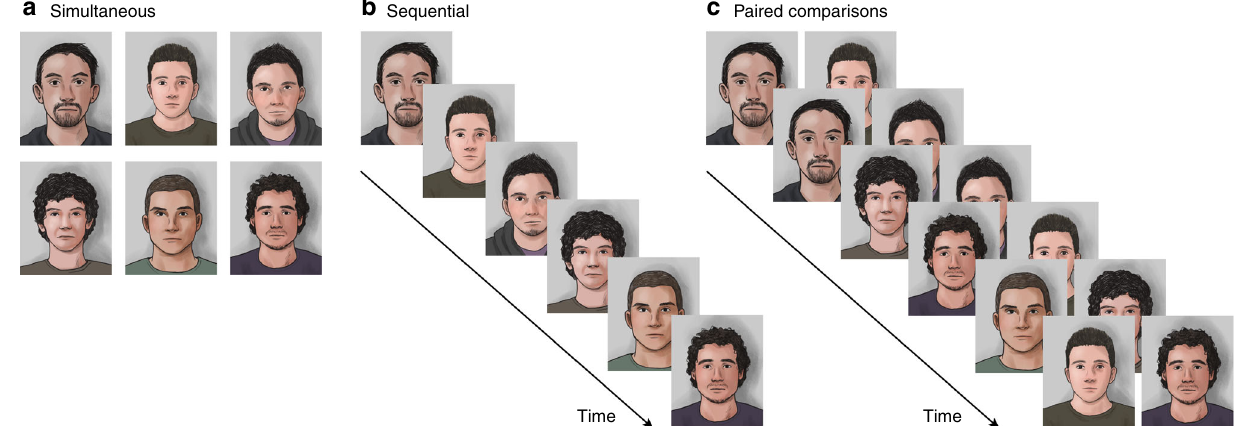
Fig. 1 Three eyewitness lineups. a Simultaneous (SIM) lineup, in which six facial photographs are presented at the same time. b Sequential (SEQ) lineup, in which six photographs are presented one at a time. In both SIM and SEQ lineups, subjects are asked to identify the perpetrator or to reject the lineup if no face is recognized from the crime. c Paired comparison (PAR) lineup, in which facial photographs are presented in pairs. Upon viewing each pair, subjects are required to report (in a two-alternative forced choice task) which of the two faces is more similar to memory of the perpetrator. For the present experiment there were 15 possible pairs; each pair was presented three times in random order (a small subset of face pairs is shown in c